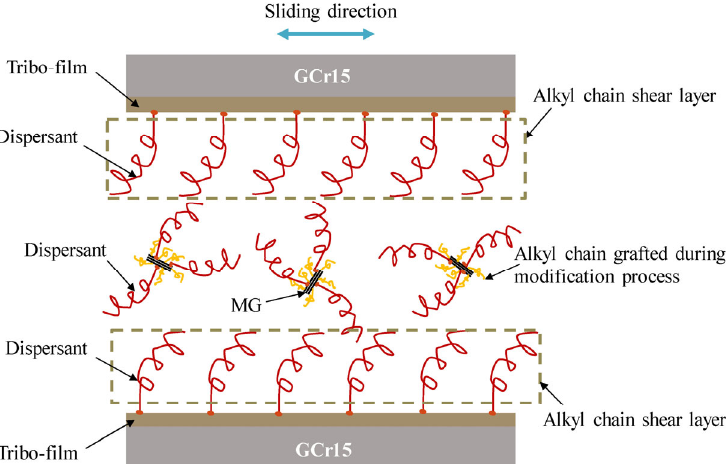
Fig. 9 Schematic diagram of the lubrication mechanism when PAO-6 with MG and dispersant was employed as